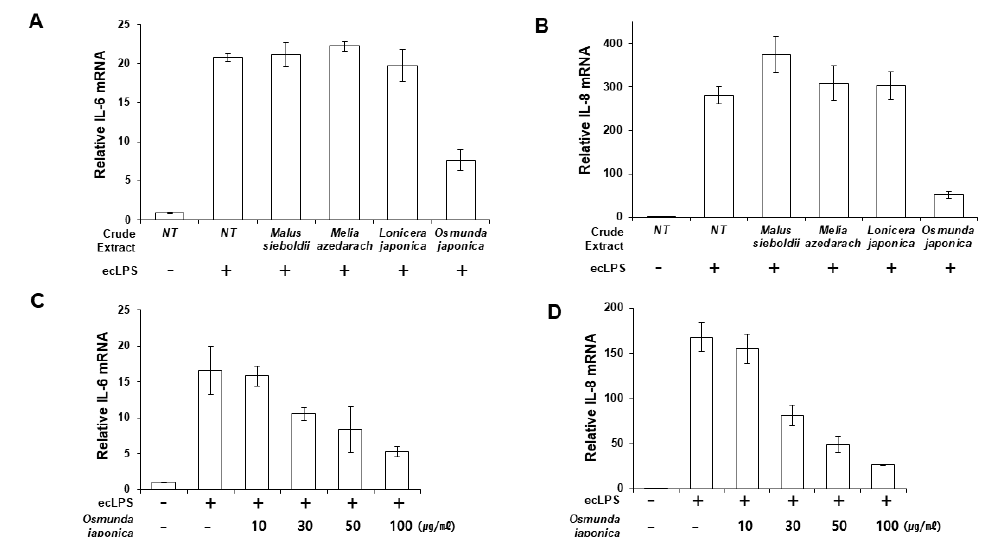
Figure 1. Osmunda japonica extract ( OJE ) inhibits pro-inflammatory cytokine expression in response to E. coli LPS (ecLPS). Human PDLFs were stimulated with ecLPS in the presence or absence of the plant extracts. ( A , B ) PDLFs were pre-treated with 100 µg/mL of various plant extracts and then incubated with ecLPS (1 µg/mL) for 12 h. After the incubation, real-time polymerase chain reaction (PCR) was performed to detect messenger RNA (mRNA) expression of IL-6 (A) and IL-8 (B). ( C , D ) Dose-dependent effects of the OJE on IL-6 ( C ) and IL-8 ( D ) mRNA expression after 12 h of ecLPS (1 µg/mL) stimulation. The values are the mean ± standard deviation of triplicate assays.